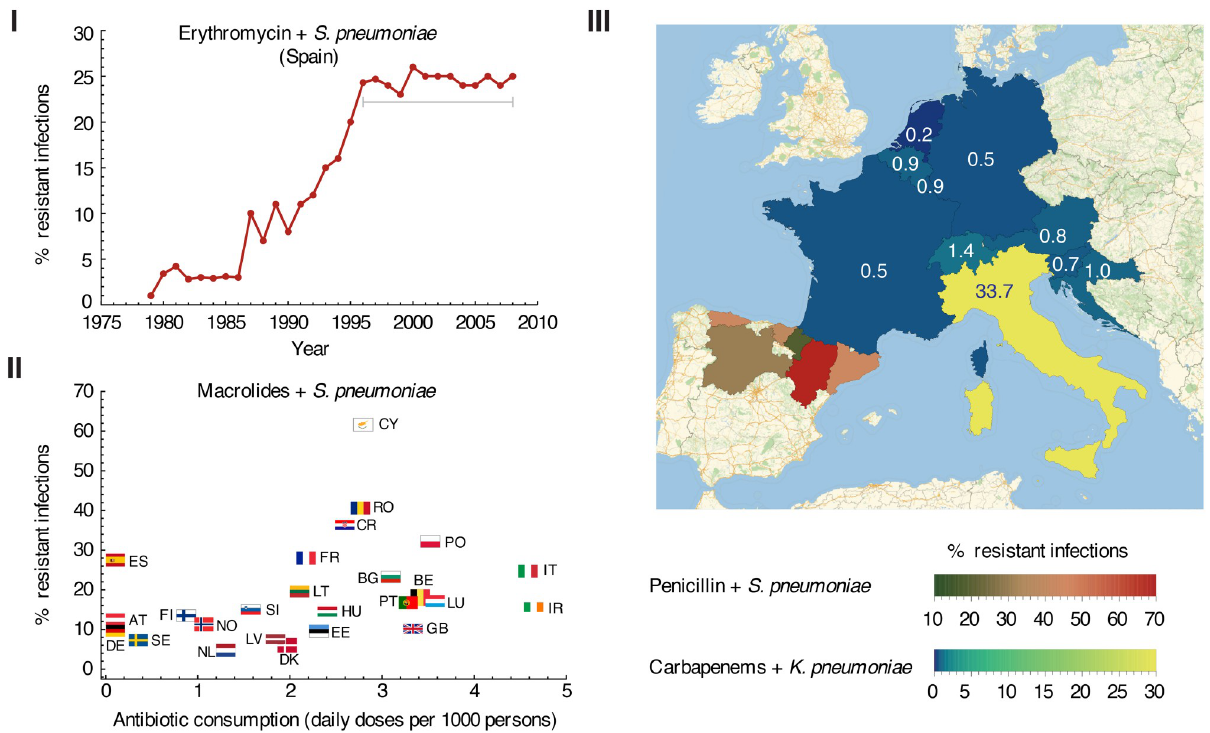
Fig 1. A selection of data illustrating spatiotemporal patterns of antibiotic resistance that common mathematical models have difficulty explaining. I) Percentage of S. pneumoniae isolates in Spain which are resistant to erythromycin (a macrolide), over time. After an initial increase, drug-sensitive and drug-resistant strains have appeared to coexist stably for � 15 years. [12]. II) The same amount of antibiotic use can lead to very different levels of resistance in different regions. Percentage of S. pneumoniae isolates from 2016 that were resistant to macrolides versus the number of daily doses of macrolides administered per capita, for each country participating in the European Centres for Disease Prevention and Control [13–16]. III) Neighboring regions can have vastly different rates of resistance which persist for long time periods. Time-averaged percent of K. pneumoniae isolates resistant to carbapenems in Austria, Belgium, Croatia, France, Germany, Italy, Luxembourg, and Slovenia from 2013-2016 and Switzerland from 2015-2016 [14, 17] (blue/yellow), along with S. pneumoniae isolates resistant to penicillin in six provinces of Spain from 1990-1998 (green/red) [18, 19]. The year-to-year deviation from this average is less than 3% (see S1 Fig). Each country is labeled with the resistance level (%). Note that for S. pneumoniae and macrolides or penicillin, “% resistant” includes isolates classified as “non-susceptible”.